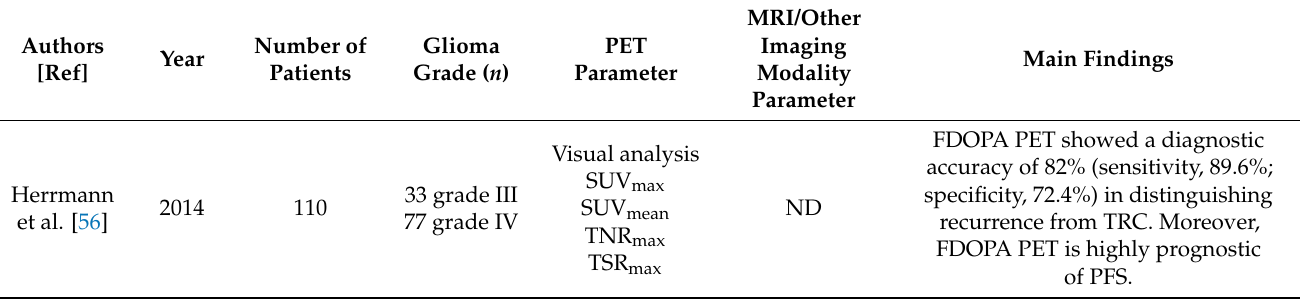
Table 2. Summary of the described studies regarding [ 18 F]FDOPA PET in glioma recurrence/differential